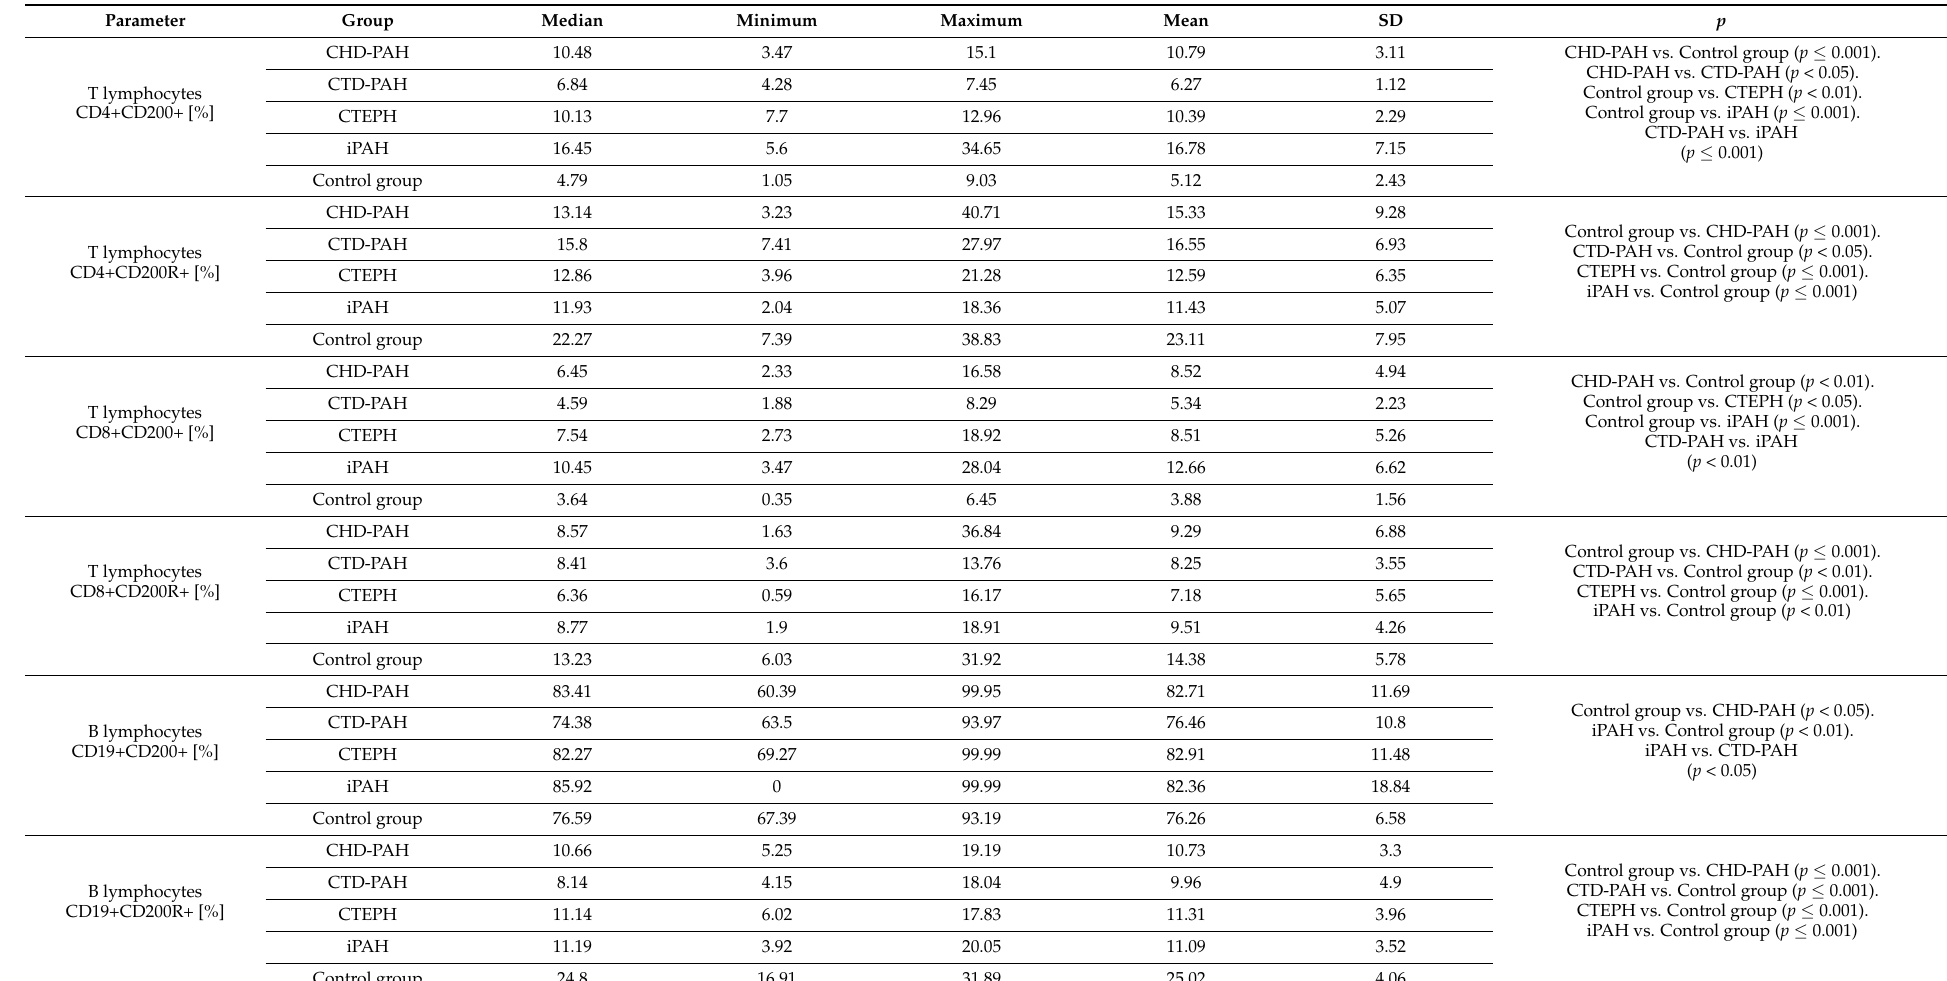
Table 4. Basic laboratory markers characterizing patients with selected types of PAH and persons from the control